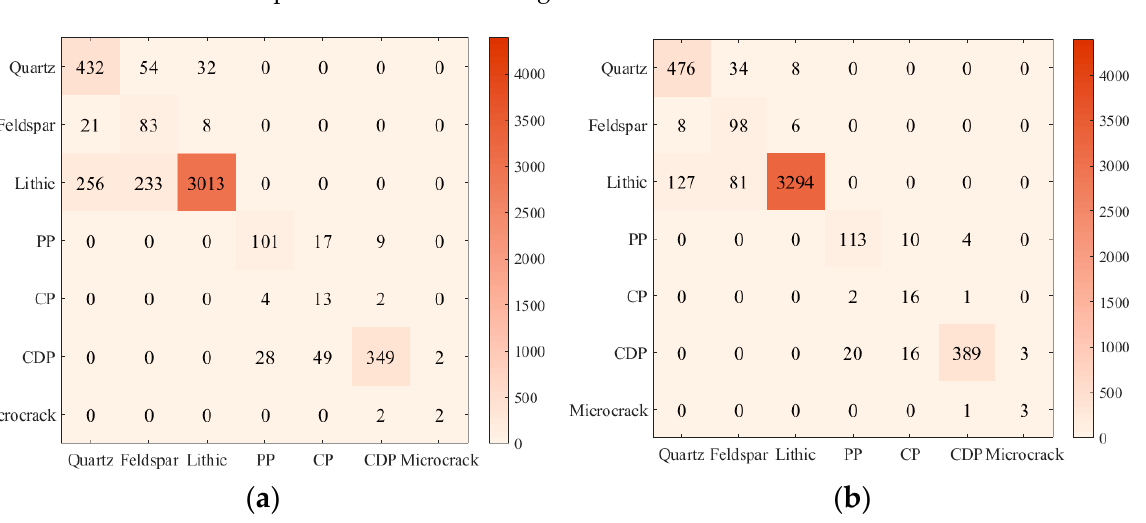
Figure 7. Error statistics between the EI, AI and Ra calculation results of each component contour of slice images and the manual calculation results between the two algorithms.